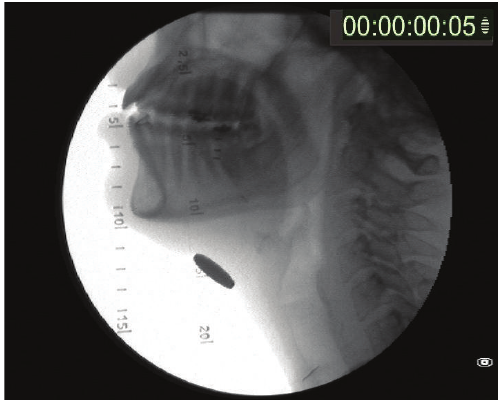
Figure 2: The anatomy of the upper aerodigestive tract is clearly identified in lateral cervical plain radiographs. Note the silhouette of the hard and soft palate, the tongue, including the tongue base, and the vallecula, and the epiglottis; the situation of the glottis can be easily estimated. The reference for the measurement of the distances is a 10 cents of eurocoin applied with adhesive tape to the midline of the neck (a constant size in any possible position: 20 mm), and there is a timer in the top right corner counting by the hundredth of a